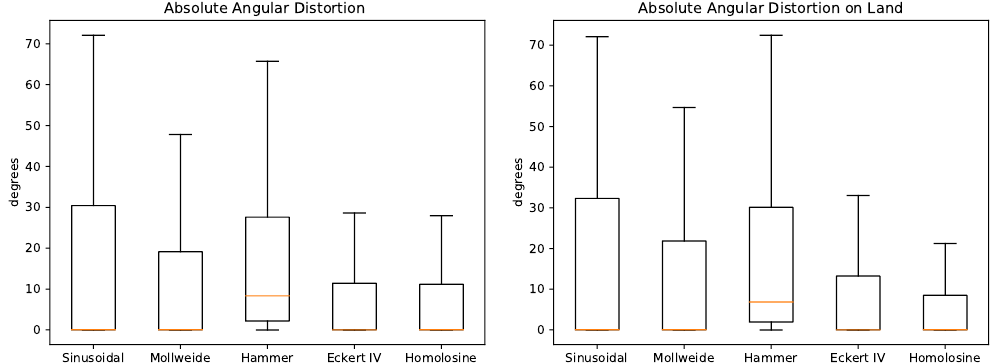
Figure 2. Box plots of absolute angular distortions (median in